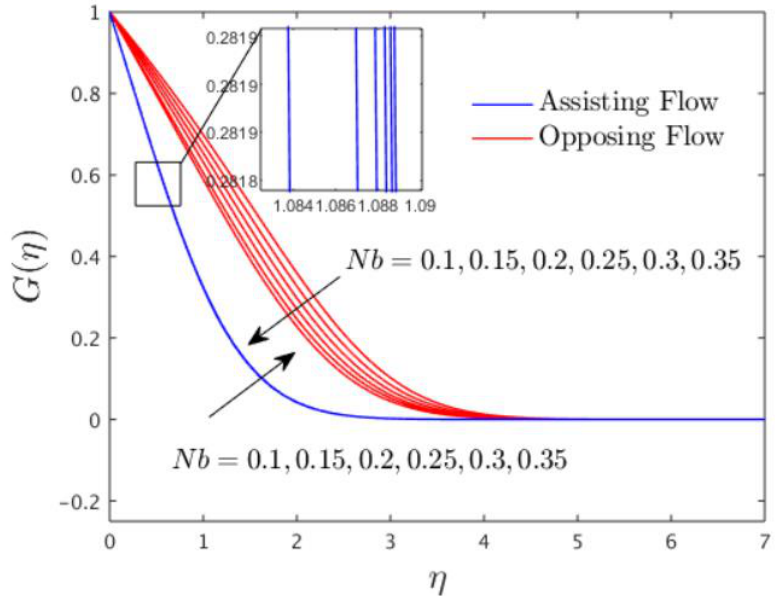
Figure 10. G ( η ) against Nb Figure 10.   G  against Nb .